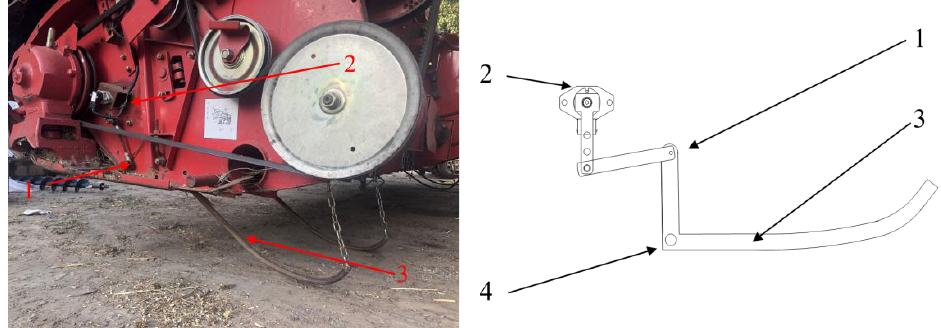
Figure 2. Structural principle of the profiling sensor mechanism. 1. Articulated link; 2. Angle sensor; 3. Profiling roller; 4. Fixed rotation point.